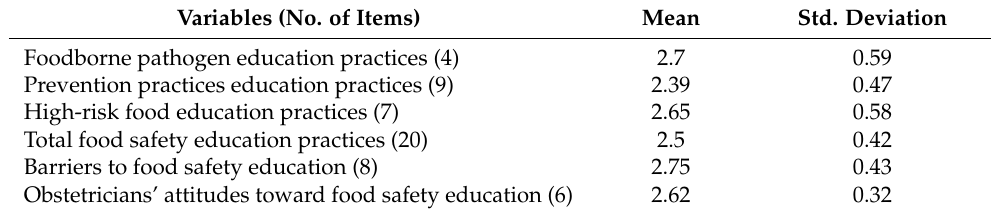
Table 2. Obstetricians’ practices, attitude, and barriers mean score regarding food safety education. Variables (No. of